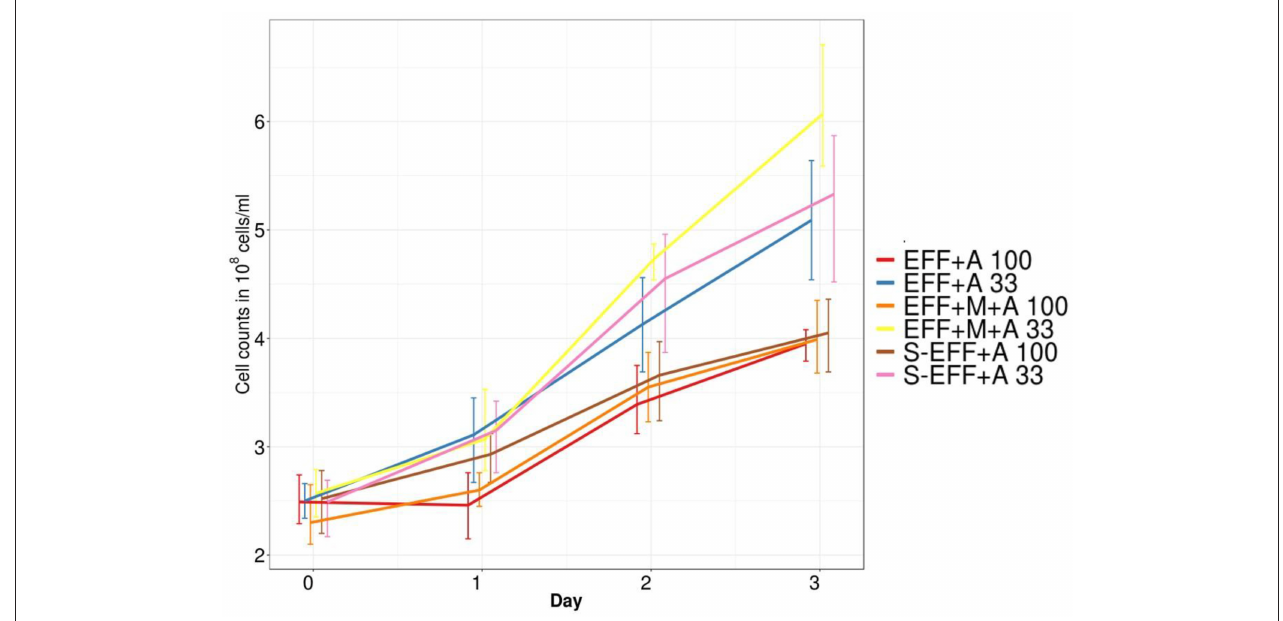
FIGURE 1 | Variation in algal cell numbers measured by counting colony forming units. All diluted samples have higher colony forming units compared to the non-diluted samples. This variation can be attributed to the lower light penetration in the non-diluted samples.